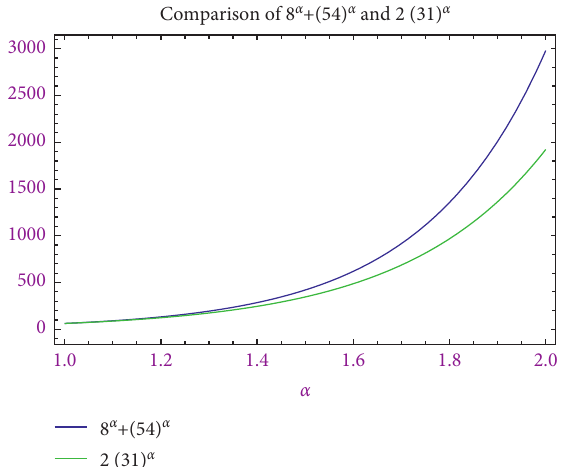
Figure 8: A graph for the degree sequence d ∗ and L � 1.